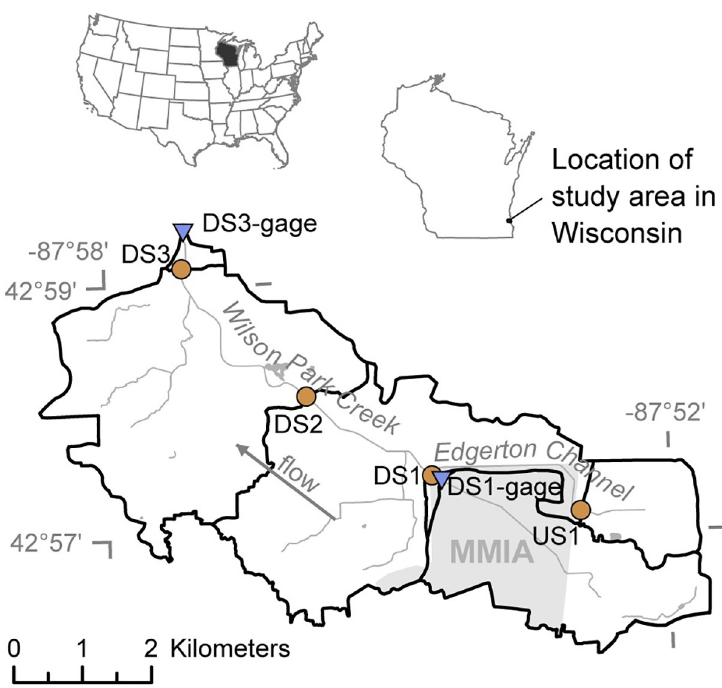
Fig 1. Location of study area and sampling sites. Brown circles indicate biofilm sampling sites and blue triangles indicate stream gages. Light gray area represents Milwaukee Mitchell International Airport (MMIA) grounds.